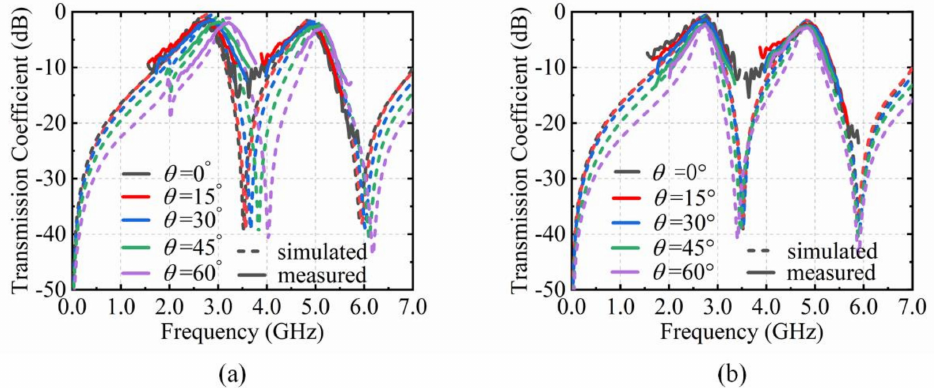
Figure 9. Comparison of measurement results and simulation. ( a ) Transmission coefficient with the incident angle from 0 ◦ to 60 ◦ . ( b ) Transmission coefficient for angular dispersion compensation by tuning C v 1 and C v 2